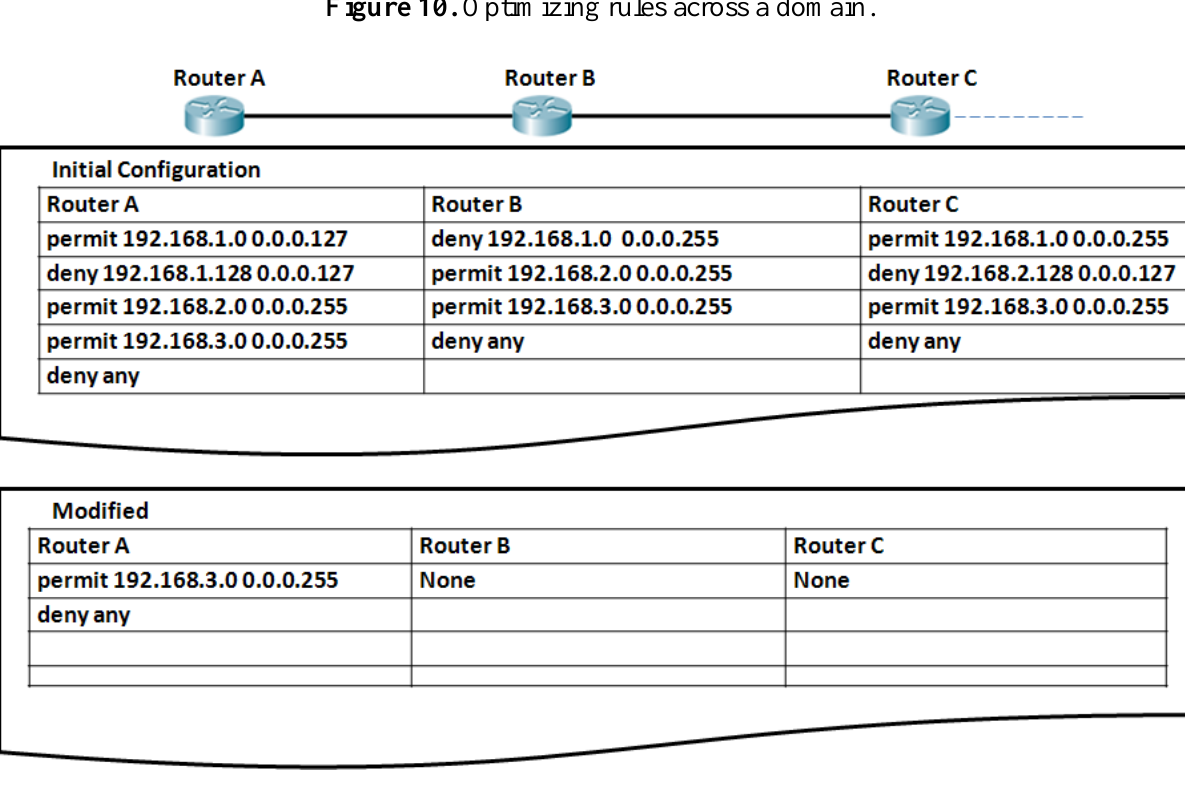
Figure 10. Optimizing rules across a